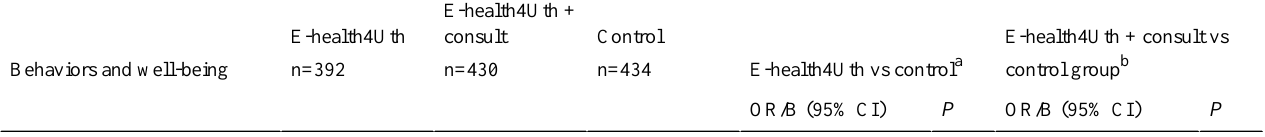
Table 2. Follow-up health behaviors and well-being of adolescents and effects of the interventions with the control group as reference